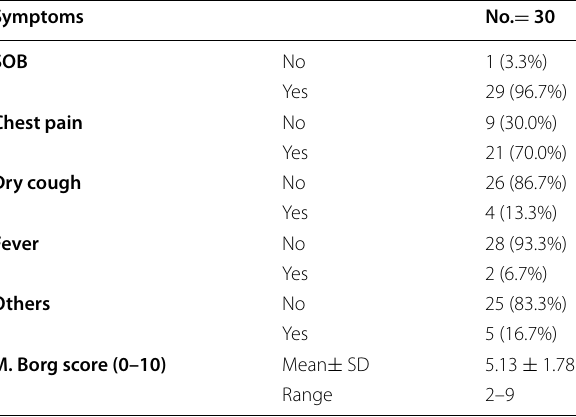
Table 2 Different presentation of the studied